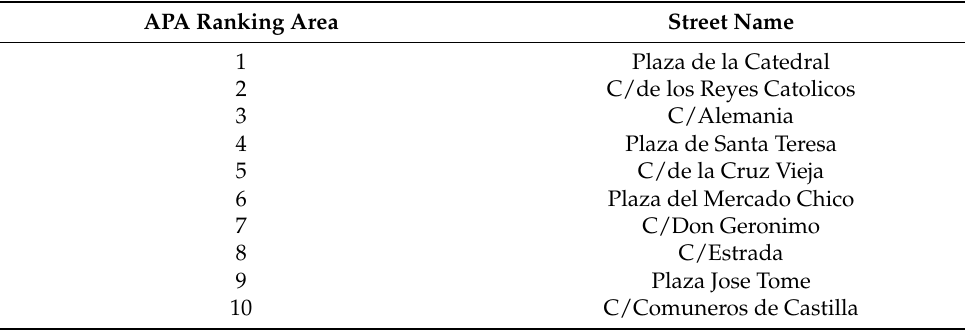
Table 5. Top 10 classification of the commercial areas using the APA centrality index. APA Ranking